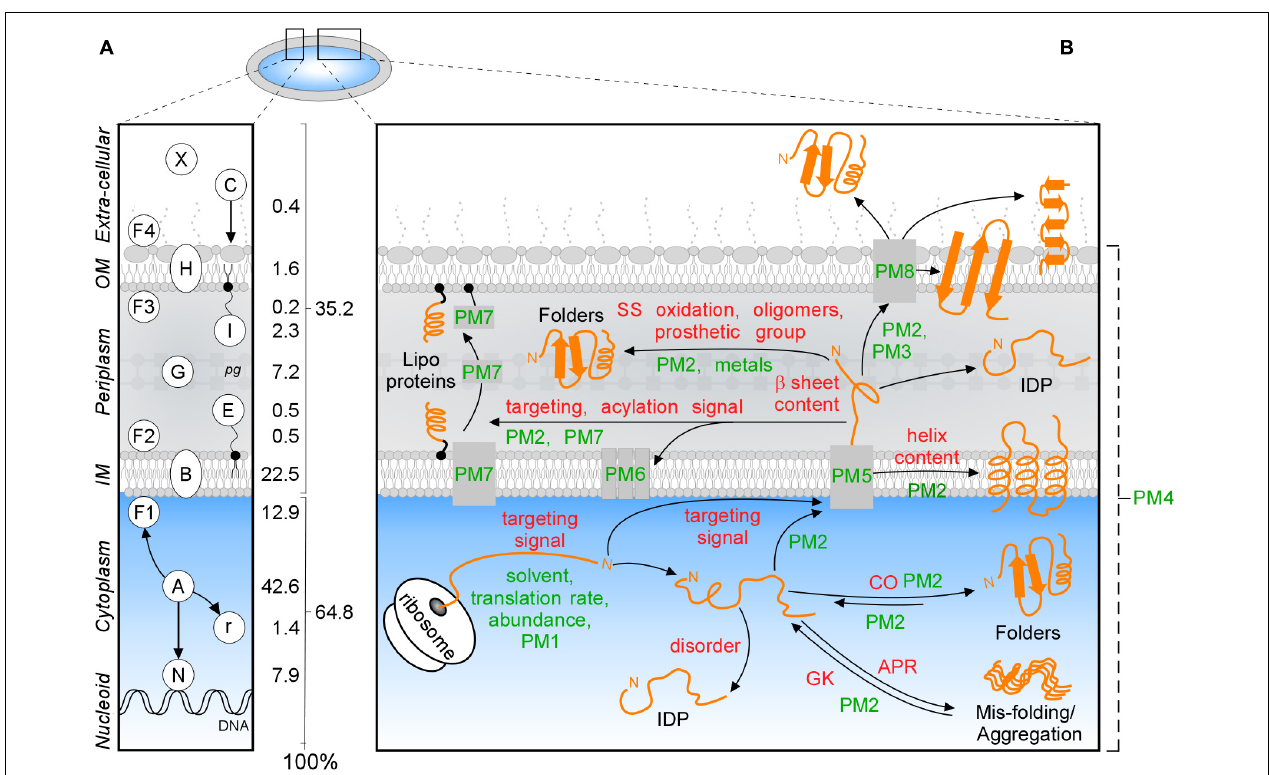
FIGURE 1 | Subcellular protein distribution in K-12. (A) Cartoon representation of an Escherichia coli cell that comprises the cytoplasm surrounded by the inner (IM) and outer (OM) membranes separated by periplasm with peptidoglycan (pg). The symbols of different classes are noted as letters in the left box, the percentages of the whole K-12 proteome are in the right box. In K-12, cytoplasmic proteins include those binding to the nucleoid (N), peripheral inner membrane (F1), associated with ribosomes (r) or are freely diffusing (A); Exportome is either embedded in the IM (B) or comprises the secretome. These are proteins translocated across the IM: periplasmic enzymes (G), lipoproteins (I, E), OM-embedded proteins (H), IM and OM peripherally associated periplasmic proteins (F2, F3), surface-exposed appendages like flagella, fimbriae, and curli or are fully secreted to the extracellular space (X) and colicins (C) are imported through the cell envelope. (B) Intrinsic factors (red) and extrinsic (green) that bias the diffusion of a protein (orange) toward its final destination and folding. Proteostatic machineries (PM): PM1 = chaperones residing on the ribosome (SRP, SecA, TF); PM2 = soluble chaperones; PM3 = pilotin; PM4 = proteases; PM5 = IM transport channels; PM6 = lipoprotein modification module; PM7 = lipid factors; PM8 = OM insertion machineries (Bam and Omp). APR, aggregation prone region; CO, contact order; IDP, intrinsically disordered protein; GK,